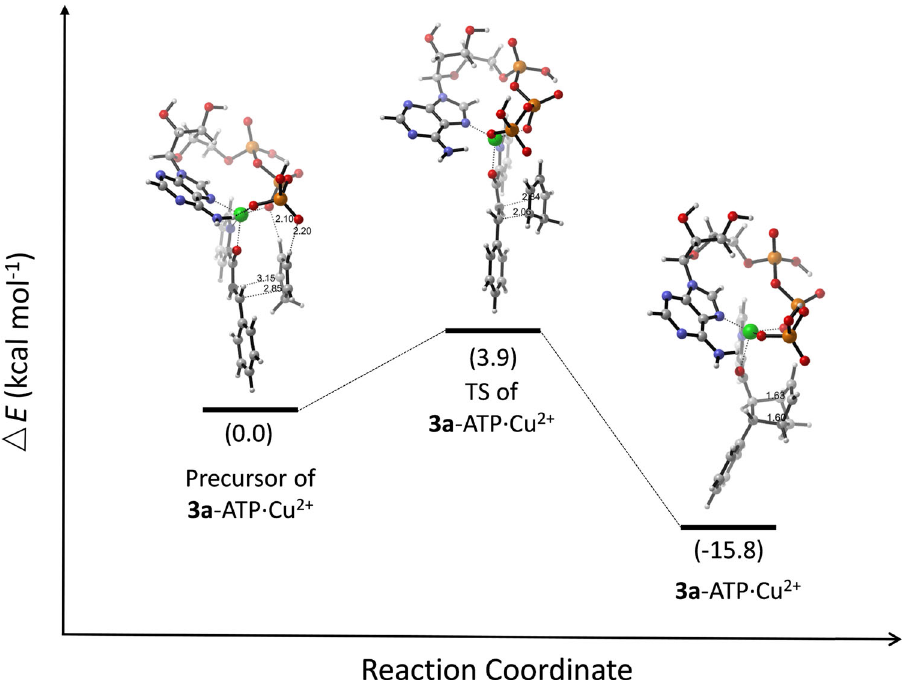
Supplementary Fig. 25. The relative electronic energy pro fi le of the reaction path for Cu 2 + ⋅ ATP-catalyzed Diels – Alder reaction of 1a and 2 that yields 3a (endo) in the absolute con fi guration of 1R, 2S, 3S, 4S. TS, transition state. which replace the previous incorrect versions: